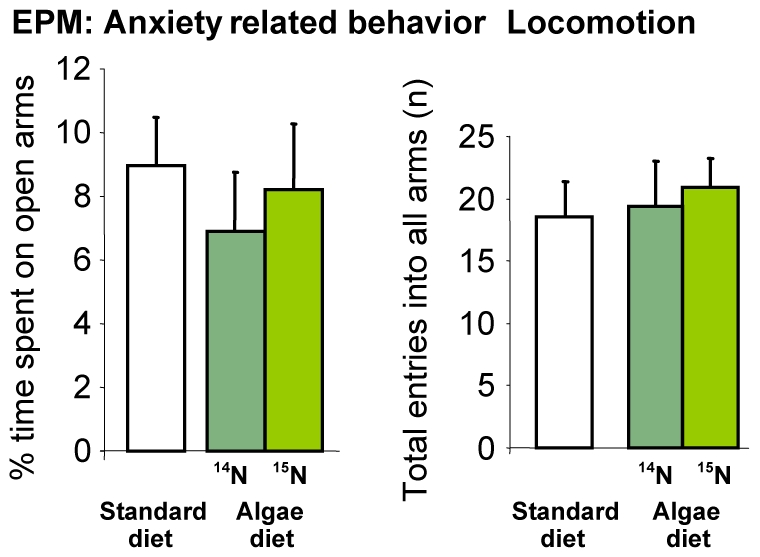
Anxiety-related behavior and locomotion of HAB animals on the elevated plus maze (EPM).No behavioral changes due to the blue-green algae diet fed to the animals were found.